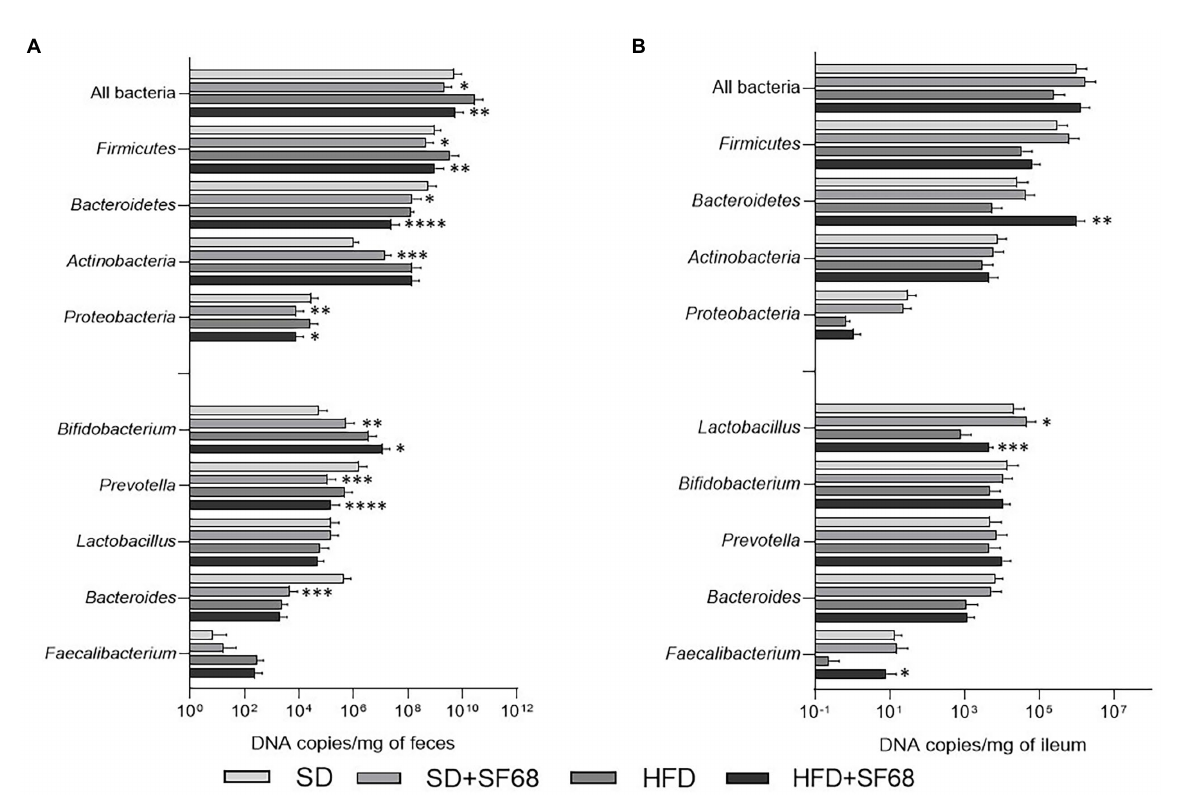
FIGURE 4 (A) Absolute abundances of total bacterial load, phyla, and genera in fecal samples of mice fed with SD or HFD with or without SF68 administration. (B) Absolute abundances of total bacterial load, phyla, and genera in ileal samples in both mice fed with SD or HFD with or without SF68 administration. Statistical comparisons were carried out between SD and SD + SF68, and HFD and HFD + SF68. * p < 0.05; ** p < 0.01; *** p < 0.001; **** p <